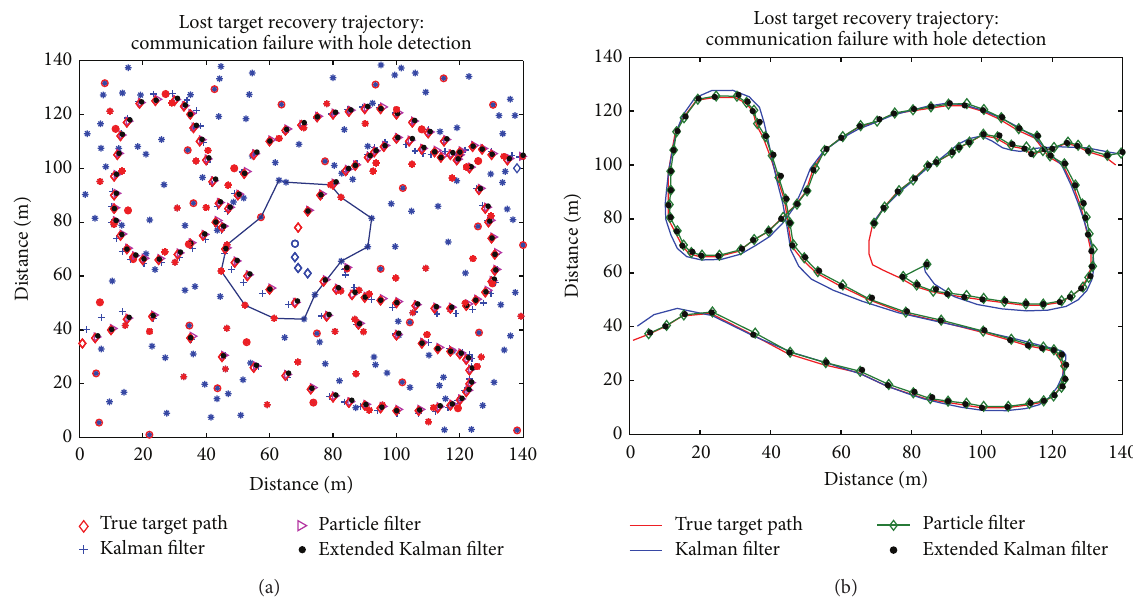
Figure 9: (a) Loss of target due to coverage hole in the WSHAN network trajectory. (b) Loss of target due to coverage hole in the WSHAN network graph.